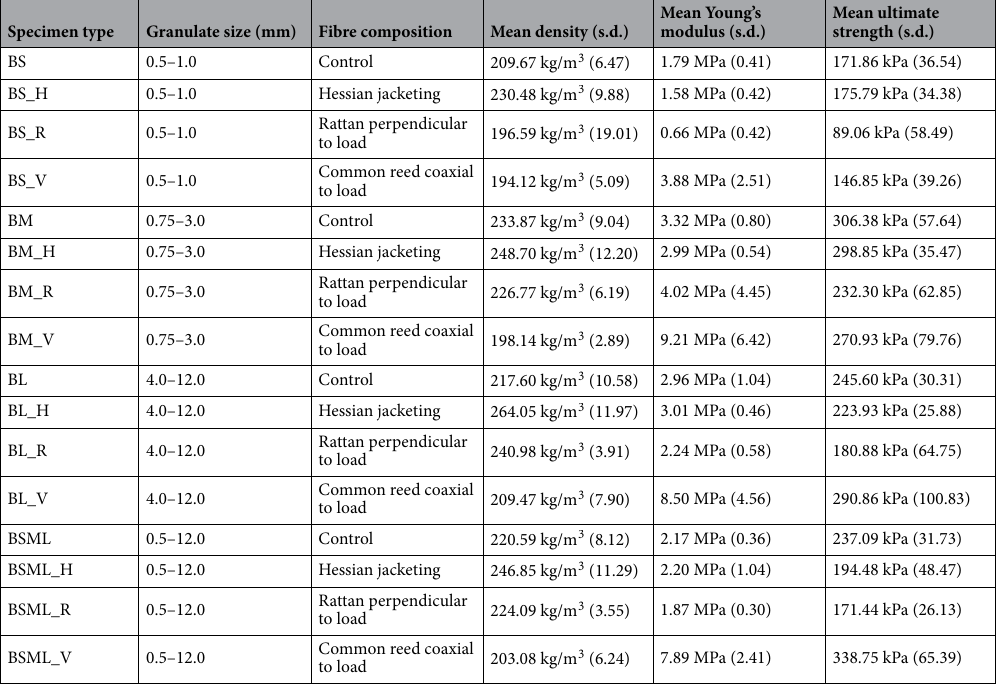
Table 1. Summary of specimen types parameters, resulting dried densities, and compressive properties.